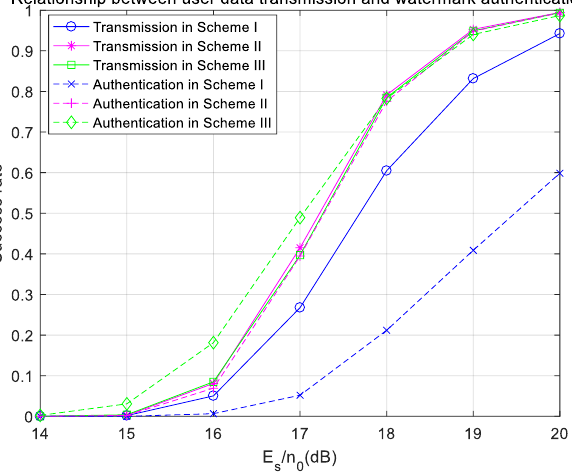
Figure 11. Success rates of user data transmission and watermark authentication under ideal syn- chronization in the Gaussian channel.